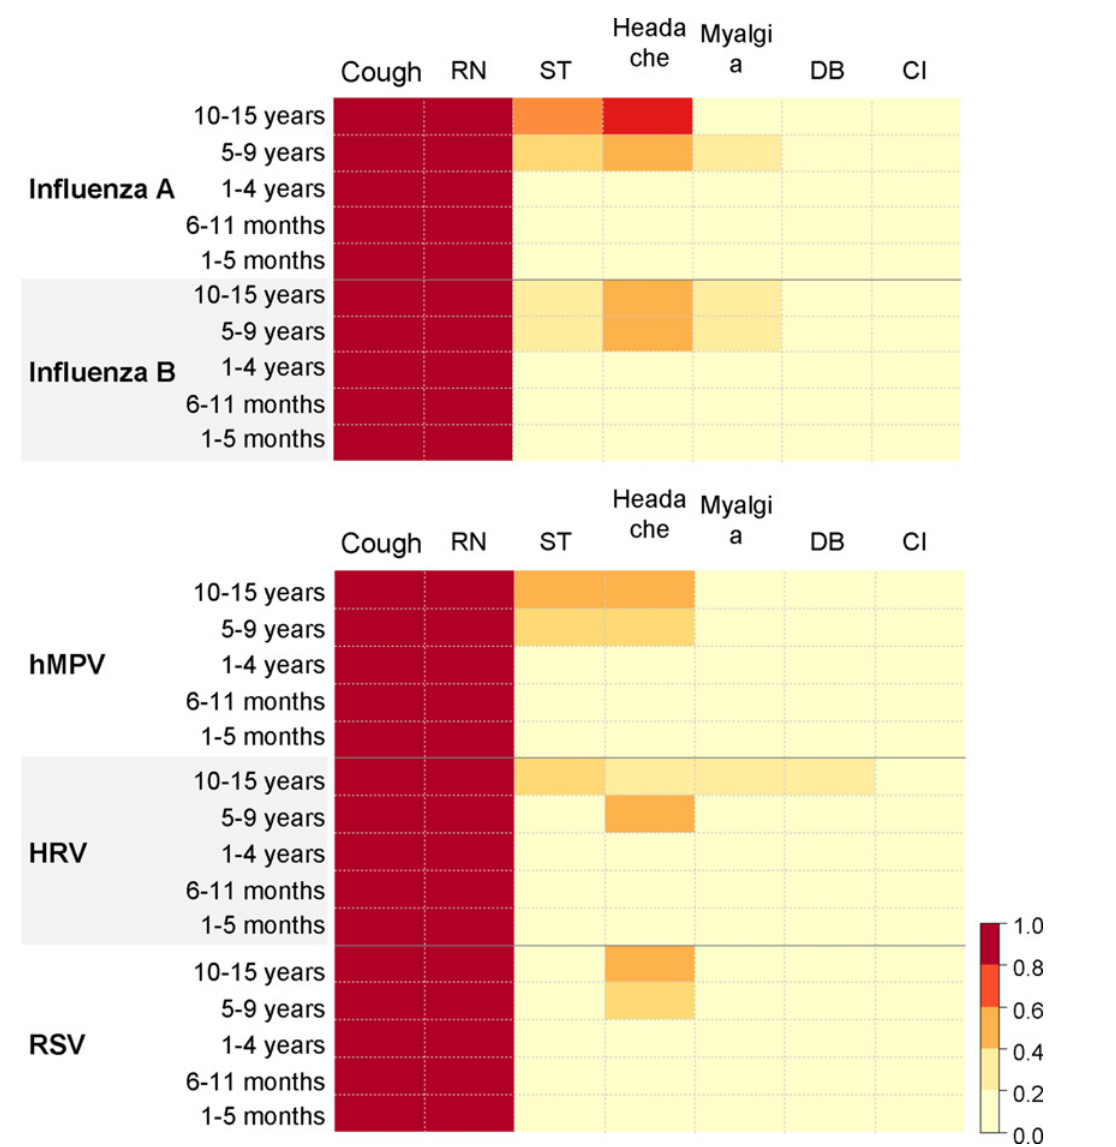
Fig 3. Frequencies of clinical manifestations presented among cases aged up to 15 years. Abbreviations: RN, runny nose; ST, sore throat; DB, difficulty in breathing; CI, chest indrawing, hMPV, human metapneumovirus; HRV, human rhinovirus; RSV, respiratory syncytial virus.